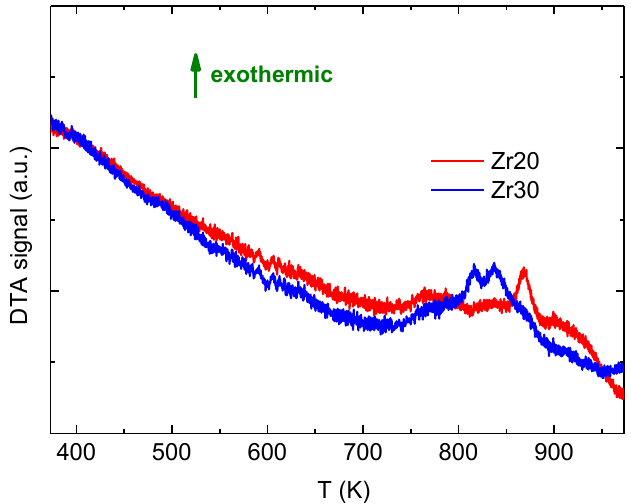
Figure 2. Differential thermal analysis (DTA) measurements on the two amorphous membranes conducted with a temperature rate of 4 K/min after subtraction of the background records with empty